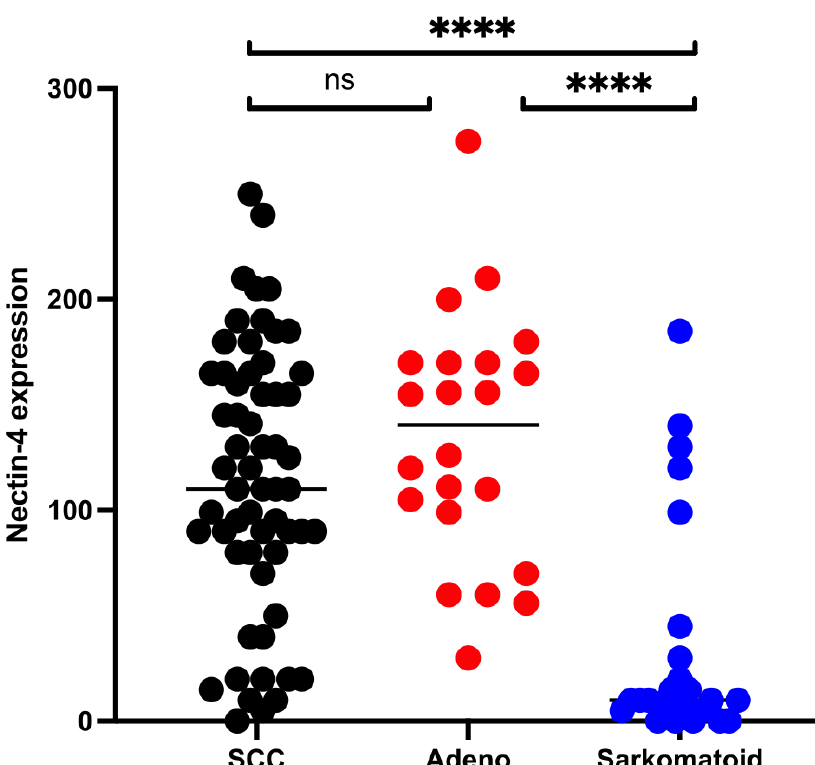
Figure 2. Nectin-4 expression (H-score) in different variant histologies of bladder cancer. Immuno- histochemical expression of Nectin-4 for patients with pure squamous cell carcinoma (SCC — black), adenocarcinoma (ADENO — red), and sarcomatoid urothelcarcinoma (SARCO — blue) was evaluated by histochemical scoring system (H-score). Group comparisons were performed by Mann – Whitney U-test; ns: not significant, ****: p < 0.001.